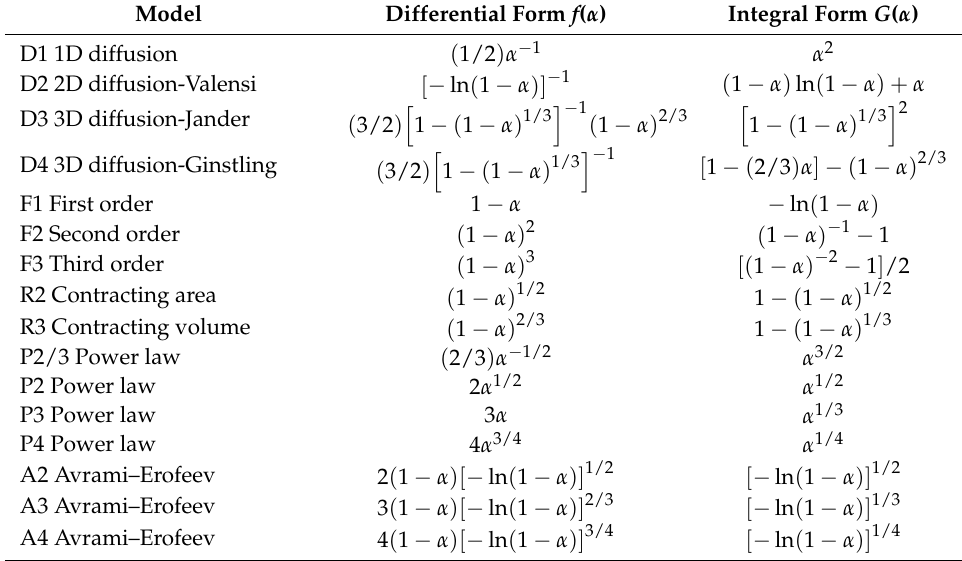
Table 3. The reaction mechanism in solid